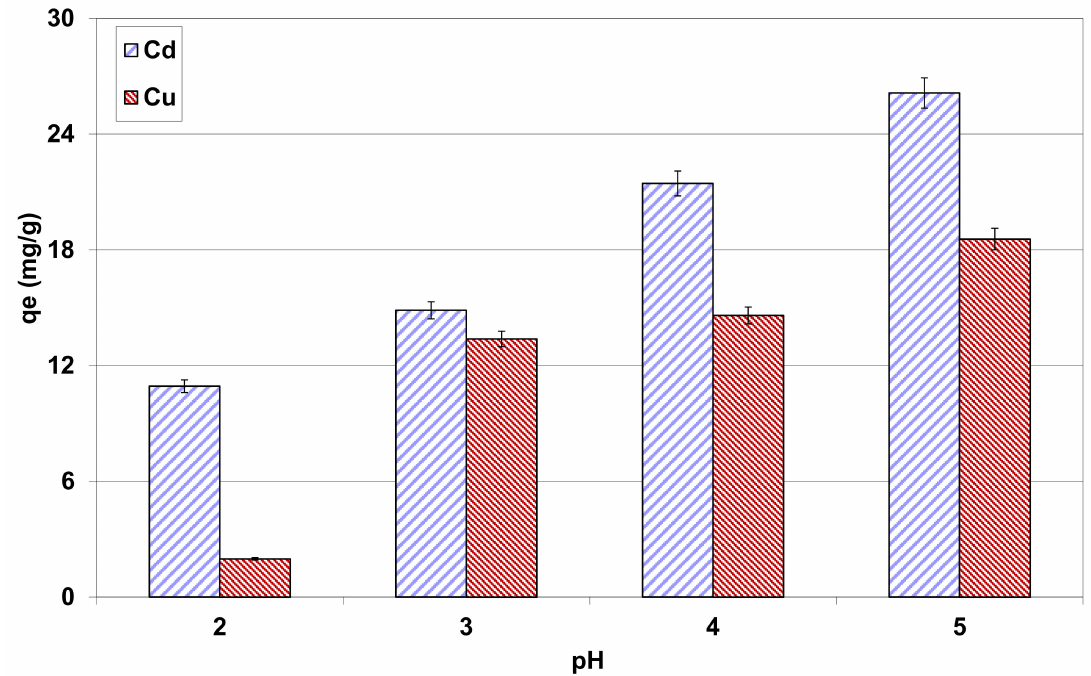
Figure 3. Impact of initial aqueous pH on Cd and Cu removal efficiency by lignite (C 0 = 100 mg L − 1 , D = 2 g L − 1 ; t = 60 min; T = 20 ± 2 ◦ C).